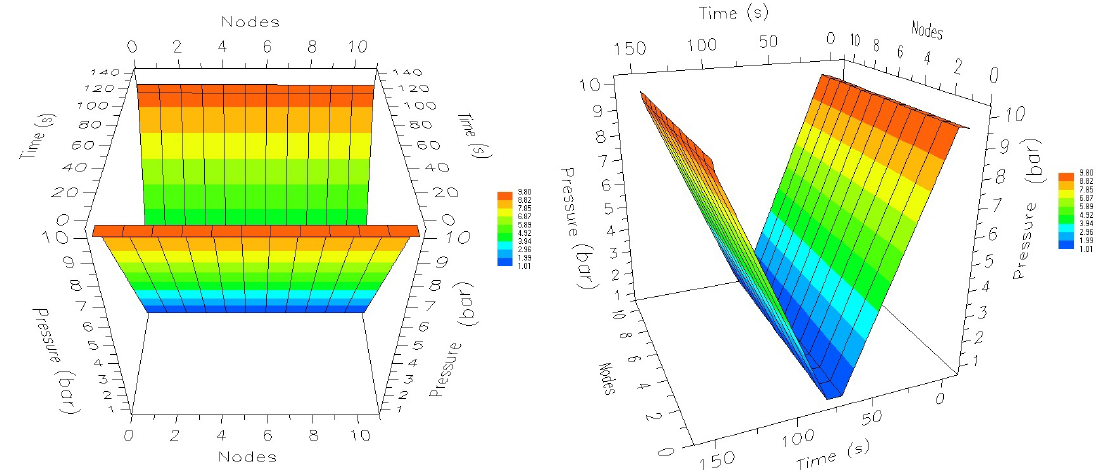
Figure 4. Pressure profiles in the CSS.